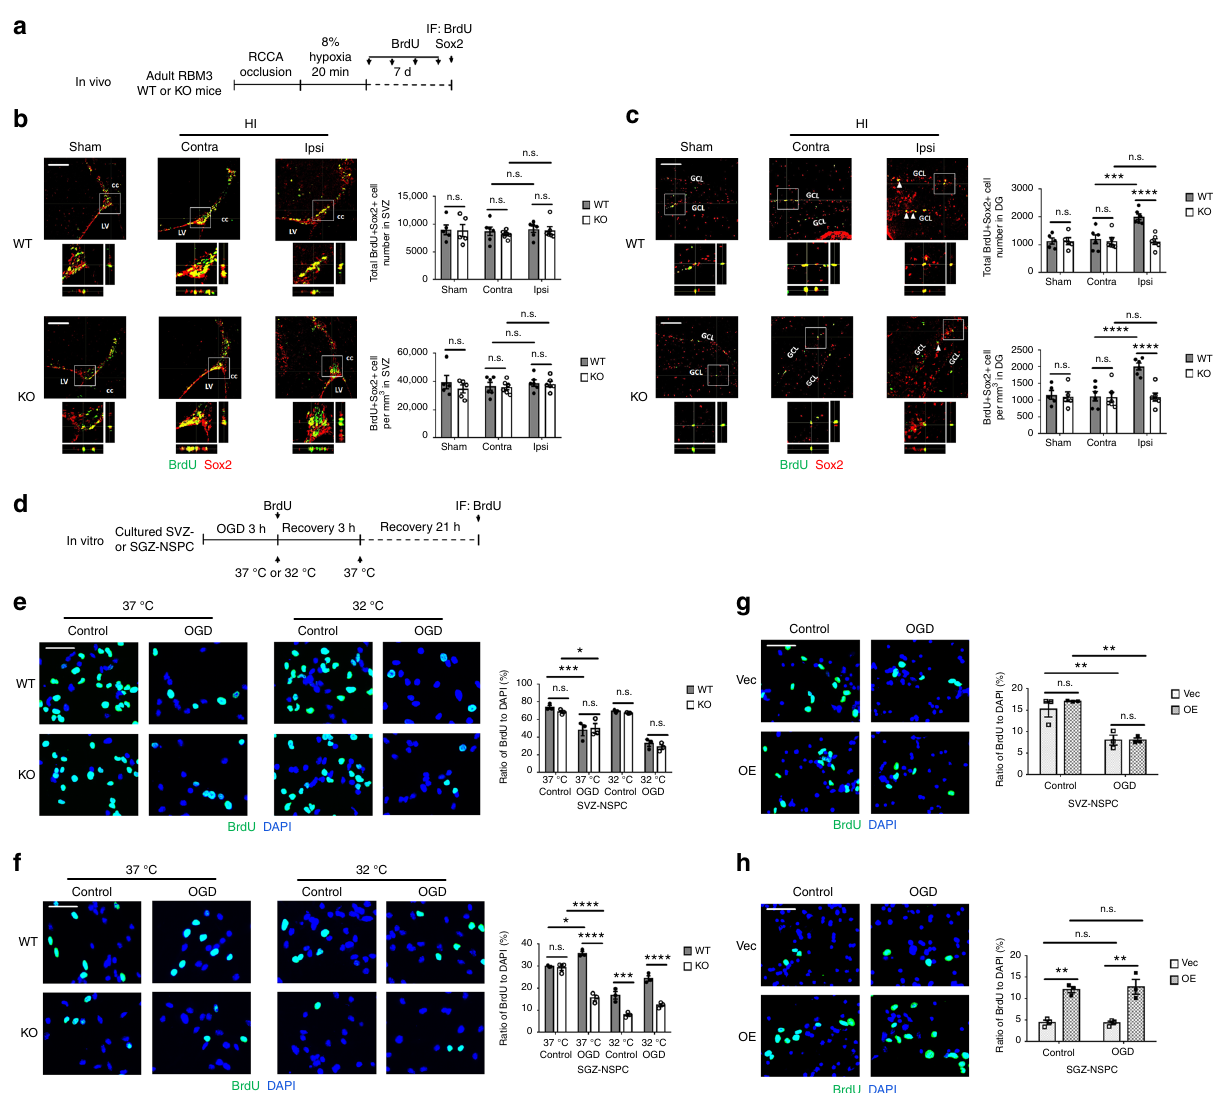
Fig. 1 RBM3 is required for HI-induced proliferation of SGZ- but not SVZ-NSPC in vivo and in vitro. a Illustration of in vivo HI model and analysis of NSPC proliferation. RCCA right common carotid artery, IF immuno fl uorescence. b , c Representative immuno fl uorescent staining of BrdU and Sox2 in SVZ ( b ) and DG ( c ) of RBM3 WT and KO animals treated with HI and recovered for 7 days with BrdU injection every other day. Animals in control group received sham surgery. Orthogonal view con fi rmed the colocalization of BrdU and Sox2. BrdU + Sox2 + cell number and density in the SVZ or DG were estimated. Five sham animals and six HI animals were counted per group (Sham: n = 5, HI: n = 6). Sham, sham group; contra, contralateral (uninjured side) in HI group; ipsi, ipsilateral (injured side) in HI group. Scale bar: 100 µ m. LV lateral ventricle, cc corpus callosum, GCL granular cell layer. Repeated measures two-way ANOVA was used for statistical analysis; n.s. not signi fi cant; *** p < 0.001; **** p < 0.0001. d Illustration of in vitro OGD model and analysis of NSPC proliferation. OGD oxygen-glucose deprivation, IF immuno fl uorescence. Only WT or KO NSPCs underwent hypothermic treatment (32 °C). Plasmid- transfected NSPCs were always cultured at 37 °C. e – h Representative immuno fl uorescent staining of BrdU and DAPI in NSPCs after OGD stress. SVZ- NSPCs ( e ) and SGZ-NSPCs ( f ) from RBM3 WT or KO mice were treated with OGD and reoxygenated in BrdU-containing medium at 37 or 32 °C for 3 h, followed by 37 °C for an additional 21 h. The ratio of BrdU + /DAPI + cells were quanti fi ed (three independent experiments, n = 3). Three-way ANOVA was used for statistical analysis; n.s. not signi fi cant; * p < 0.05; *** p < 0.001; **** p < 0.0001. SVZ-NSPCs ( g ) and SGZ-NSPCs ( h ) transfected with empty vector (Vec) or RBM3 overexpression (OE) plasmid were treated with OGD and reoxygenated in BrdU-containing medium at 37 °C for 24 h. The ratio of BrdU + / DAPI + cells was quanti fi ed (three independent experiments, n = 3). Scale bar: 50 µ m. Two-way ANOVA was used for statistical analysis; n.s. not signi fi cant; ** p < 0.01. All data are presented as mean ± SEM RBM3 promotes NSPC neuronal differentiation in SVZ and depleted mice, on the other hand, newborn neuroblast stimula- SGZ . We next examined whether RBM3 regulates NSPC differ- tion was absent in the ipsilateral SVZ and SGZ (Fig. 2b, c). In entiation and contributes to neurogenesis. long-term studies, researchers have found that most newborn In vivo, after 7 days recovery from HI treatment (Fig. 2a), NSPCs die before maturation, with the remaining cells differ- newborn (BrdU + Dcx + ) neuroblasts showed signi fi cant stimula- entiating into mature neurons as an inadequate repair of the tion in the HI ipsilateral SVZ and SGZ of WT mice compared to damaged brain tissue 18,19 . After a longer recovery period (28 days) after HI injury (Fig. 2a), only a few BrdU + cells survived in SVZ the HI contralateral and sham group (Fig. 2b, c). In RBM3- NATURE COMMUNICATIONS| (2019) 10:3983